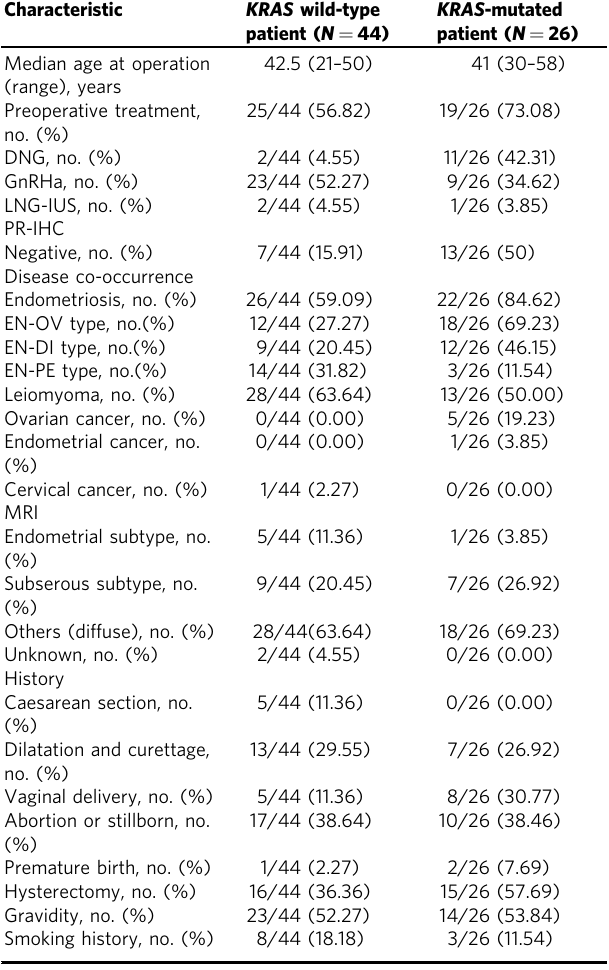
Table 1 Relationship between patients ’ characteristics and KRAS mutation status in